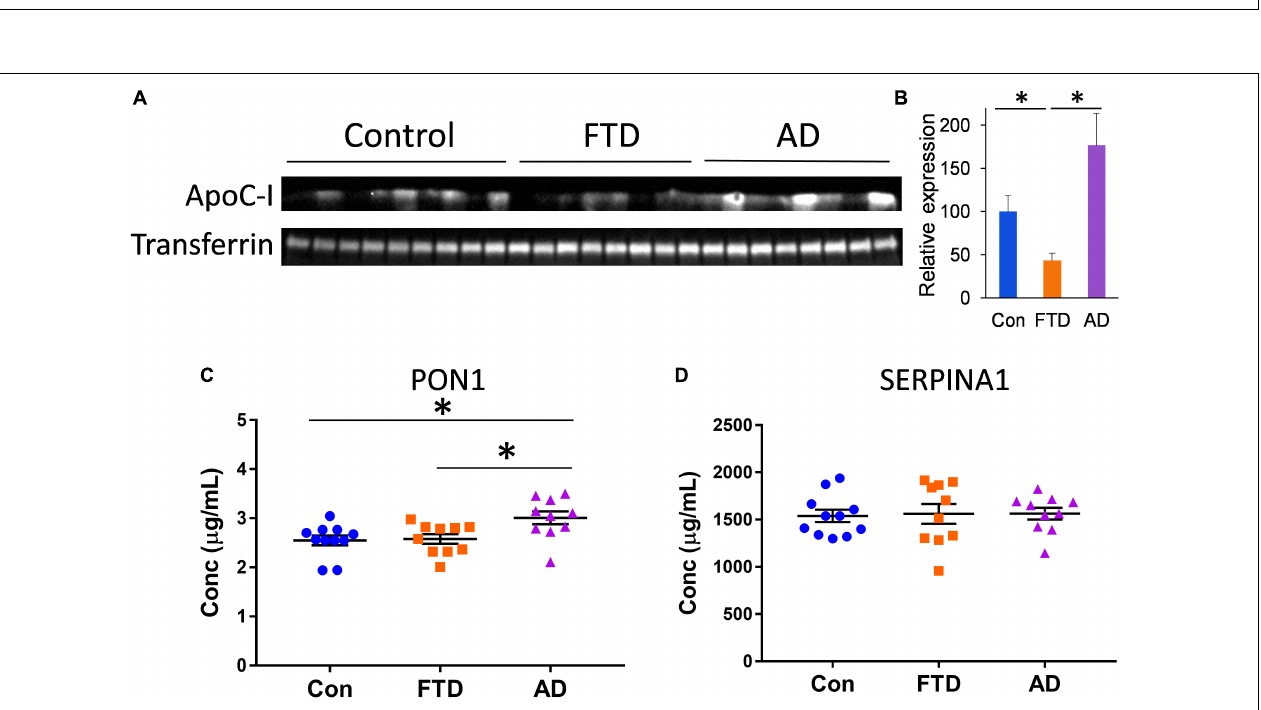
FIGURE 5 | ApoA-I levels in whole plasma in bvFTD, AD, and controls. (A) Western blotting of plasma apoA-I; transferrin was used as a loading control. (B) Relative optical density of protein bands. Data represent mean ( n = 6, 5, 6, respectively) and SE as error bars, ∗ p < 0.05. (C) HDL fraction apoA-I levels correlated positively with whole plasma apoA-I levels. (D) No significant difference between fasted and non-fasted apoA-I levels in whole plasma.